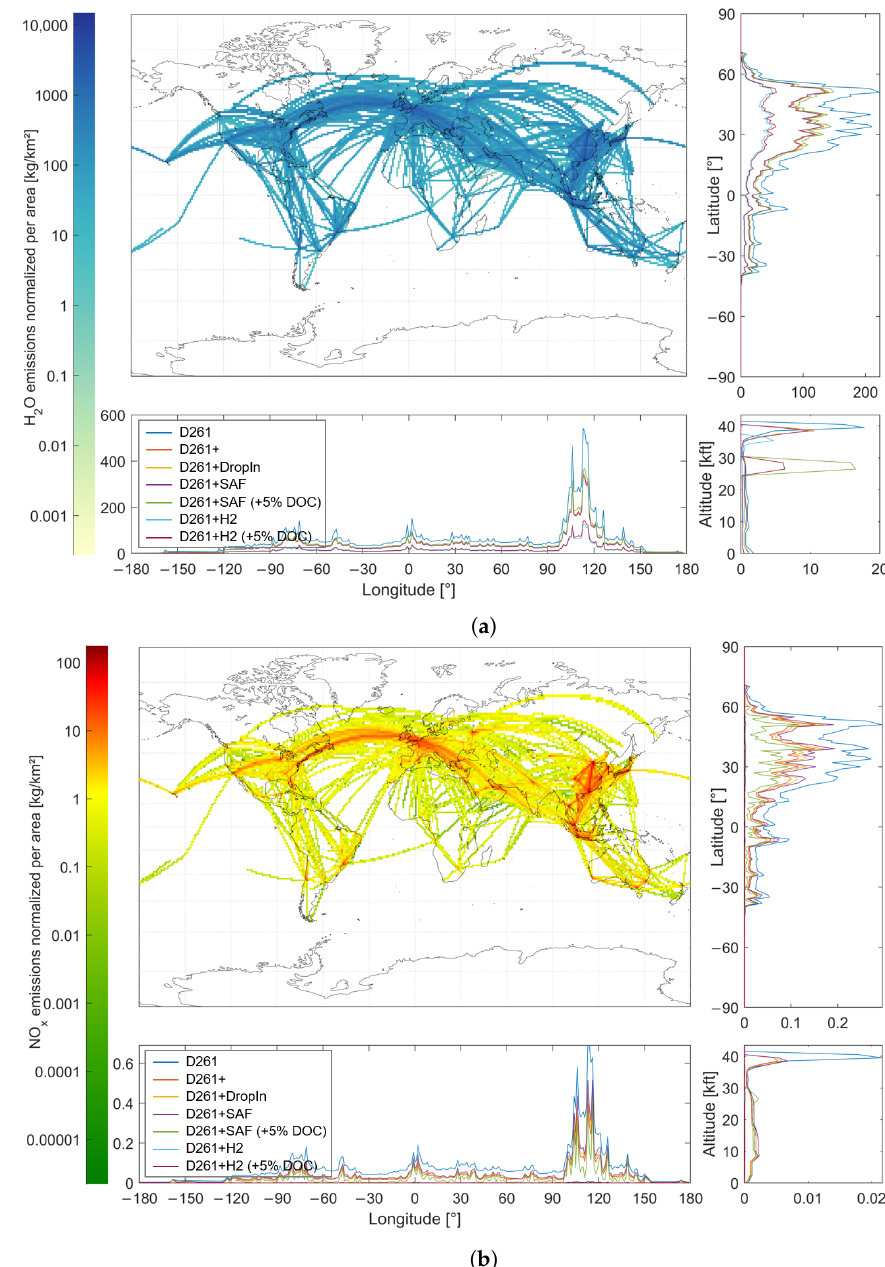
Figure A1. Global distribution of H 2 O ( a ) and NO x ( b )